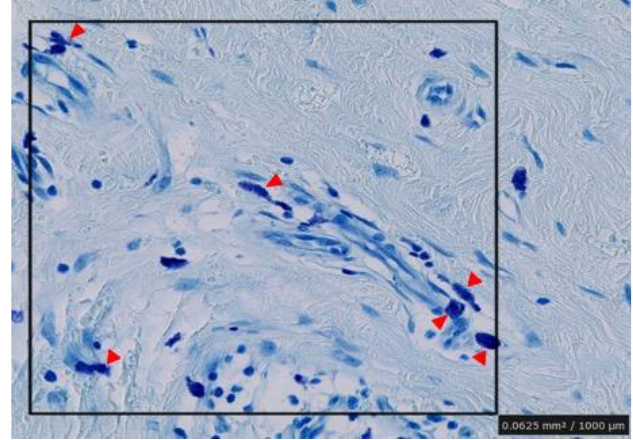
Figure 4. Counting of number of degranulated mast cells in random areas of the specimens. 1 mm 2 areas were selected in the dermal mesenchyme and the cells were counted visually in each section. Arrowheads indicate positive mast cells. Table 1. The amount of collagen in the lesion (%).